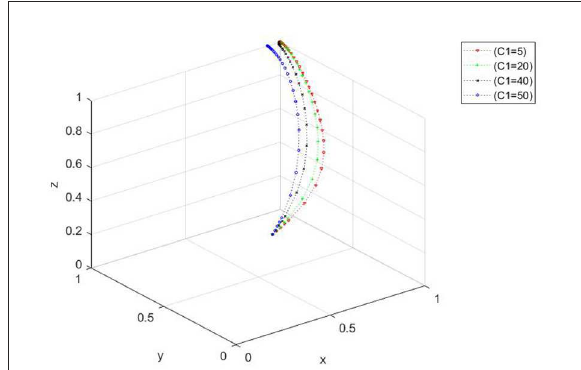
FIGURE3 Spatial diagram of the impact of the change of government investment in safety supervision costs on the evolutionary path.